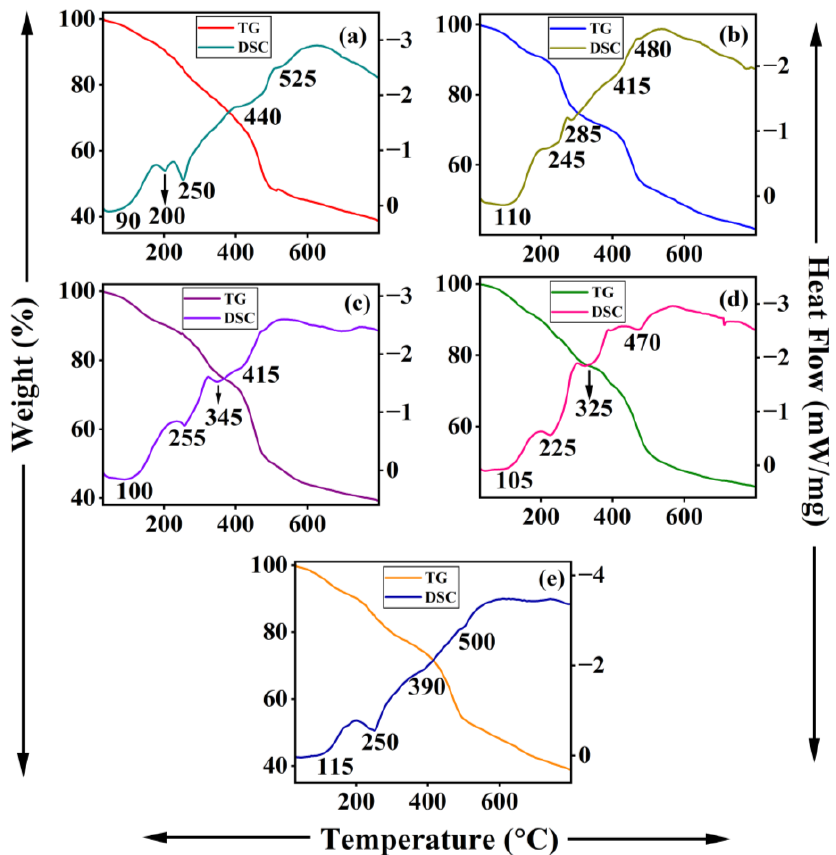
Figure 9. TG-DSC traces of Li-M-Al-DBS LDHs where M is ( a ) Mg, ( b ) Co, ( c ) Ni, ( d ) Cu, and ( e ) Zn.